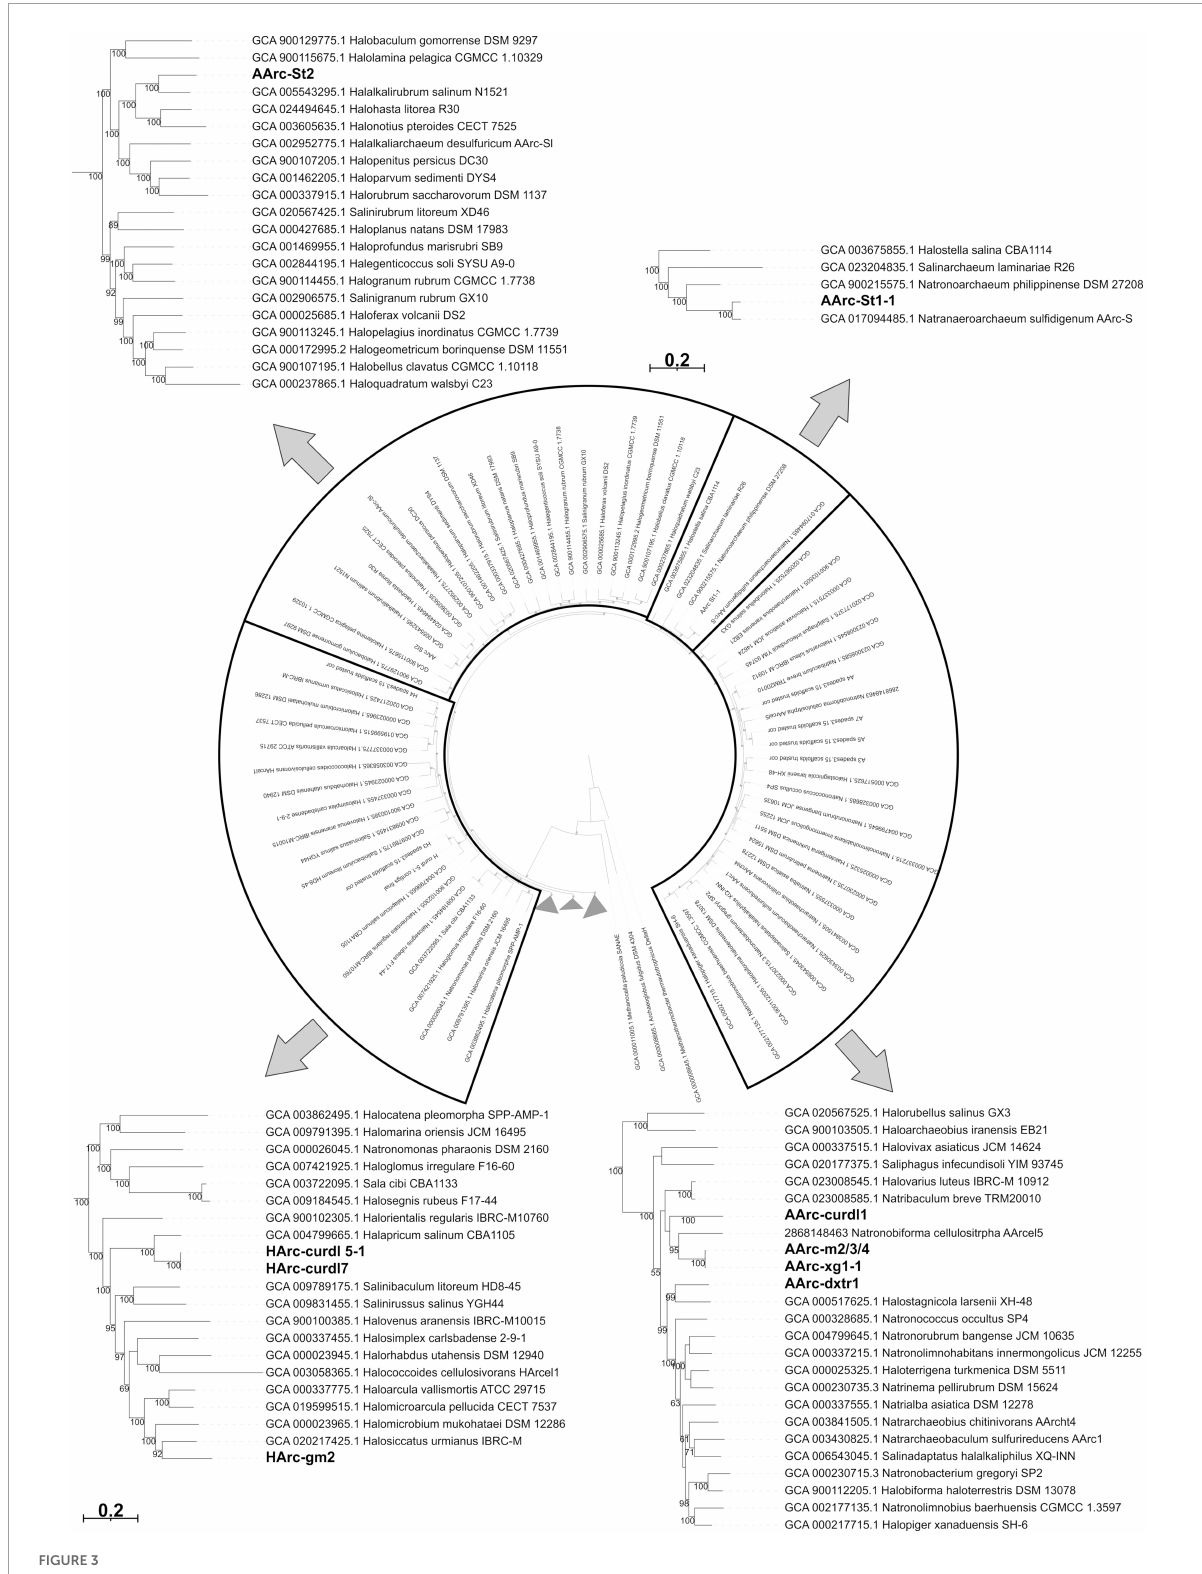
FIGURE3 Maximum likelihood phylogenomic tree showing position of polysaccharide-utilizing halo(natrono)archaea enriched from hypersaline lakes within the class Halobacteria . Sequences of 122 conserved archaeal proteins were used to infer the tree.